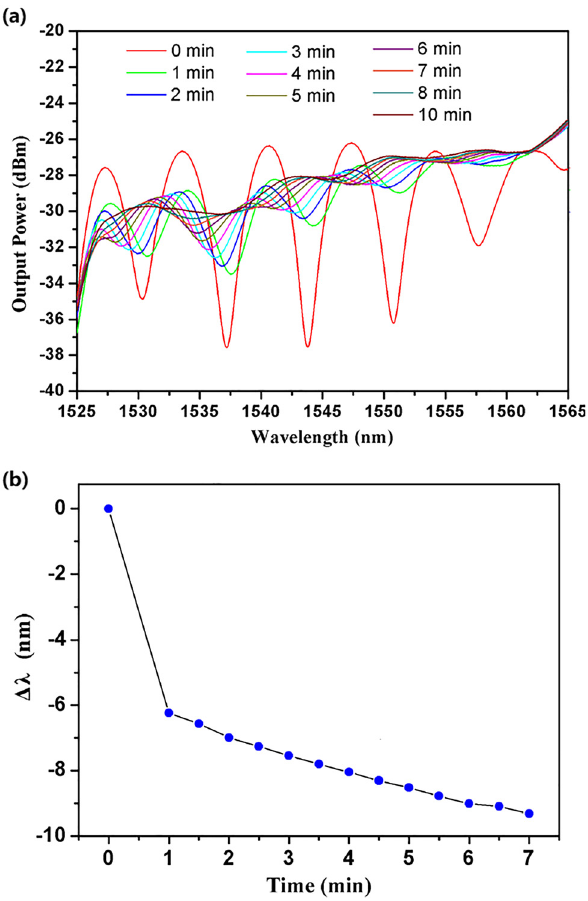
Figure 4: (a) the transmission spectra of Mach – Zehnder interferometer (MZI) during the methanol adsorption; (b) Time- dependent wavelength shift of